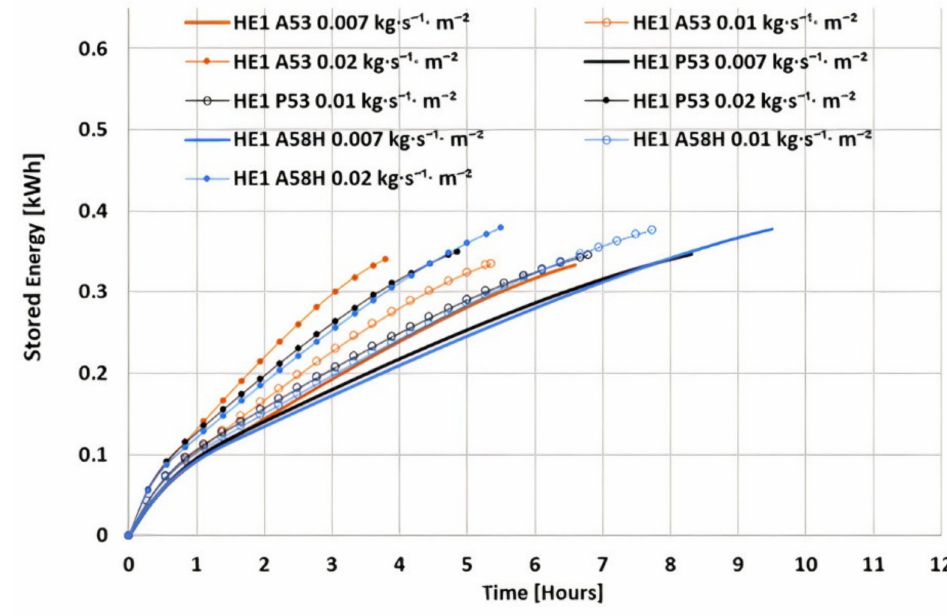
Figure 8. Stored energy during charging for all PCMs and all HTF flow rates, for